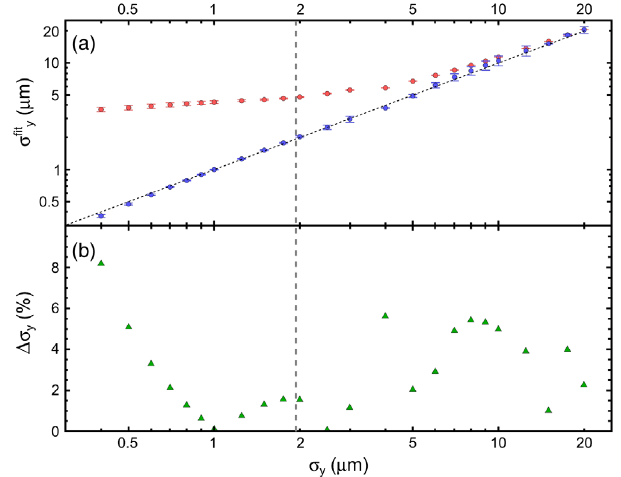
FIG. 10. Upper plot: Beam image calculated for θ m ¼ 0 . 19 , FIG. 11. (a) Comparison of two different fit functions applied to λ ¼ 400 nm, σ 1 μ m. Lower plot: Comparison of vertical y ¼ extract vertical beam sizes from calculated beam images. Param- beam profiles taken at different horizontal positions with the fit of eter set for calculation: θ m ¼ 0 . 1 , λ ¼ 400 nm, and OTR the central region according to Eq. (13). The points represent the σ -polarization component. Red points: proposed fit function calculated profiles, the solid lines the fitted curves. The horizontal Eq. (13); blue points: Gaussian fit function. The black solid line positions are x i ¼ 0 (red squares/line, σ fit y ¼ 1 . 16 (cid:3) 0 . 06 μ m), indicates ideal coincidence between input and fitted beam sizes, x =M ¼ 10 μ m (green triangles/line, σ fit 1 . 08 (cid:3) 0 . 02 μ m), the gray dashed line shows the beam size at which the visibility y ¼ i becomes equal to zero. (b) Relative difference between input and and x i =M ¼ 20 μ m (blue dots/line σ fit y ¼ 0 . 92 (cid:3) 0 . 01 μ m). fitted beam sizes according to Eq. (13).